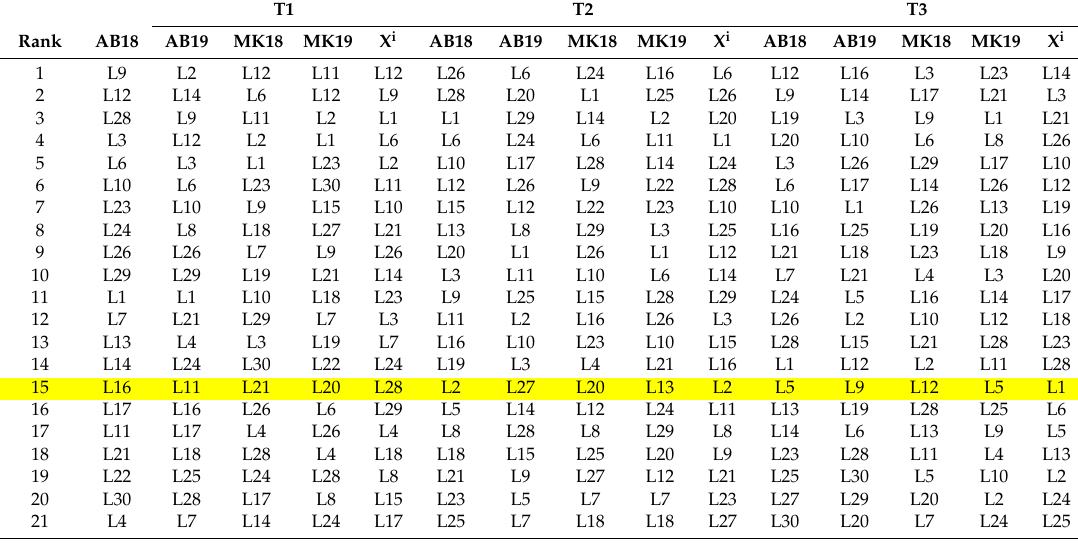
Table A8. Ranking Striga -resistant inbred lines for Striga rating (1–9 scale) at 10 WAP across